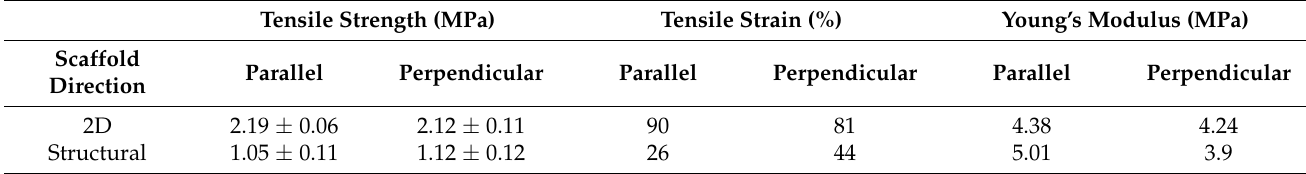
Table 1. Mechanical properties of the fabricated polycaprolactone (PCL) scaffolds. Tensile Strength (MPa) Scaffold